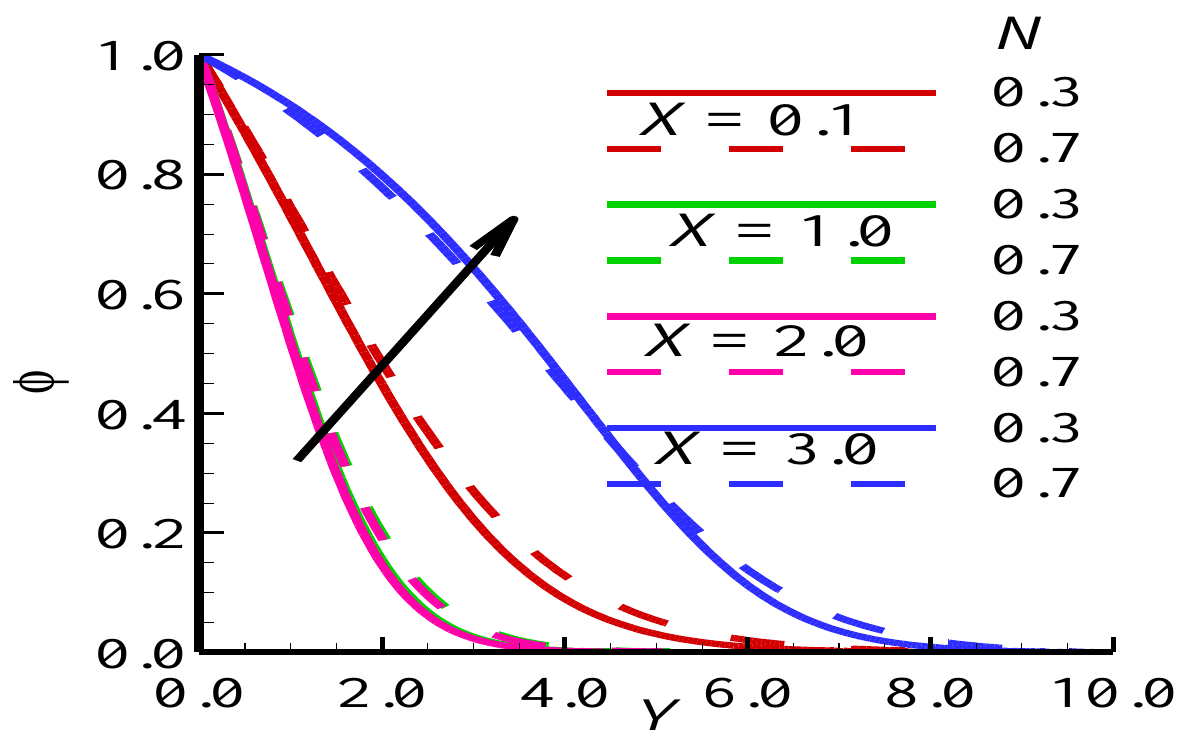
Figure3. Outcomes of radiation parameter 𝑁 on temperature distribution 𝜃 when 𝑁𝑏 =